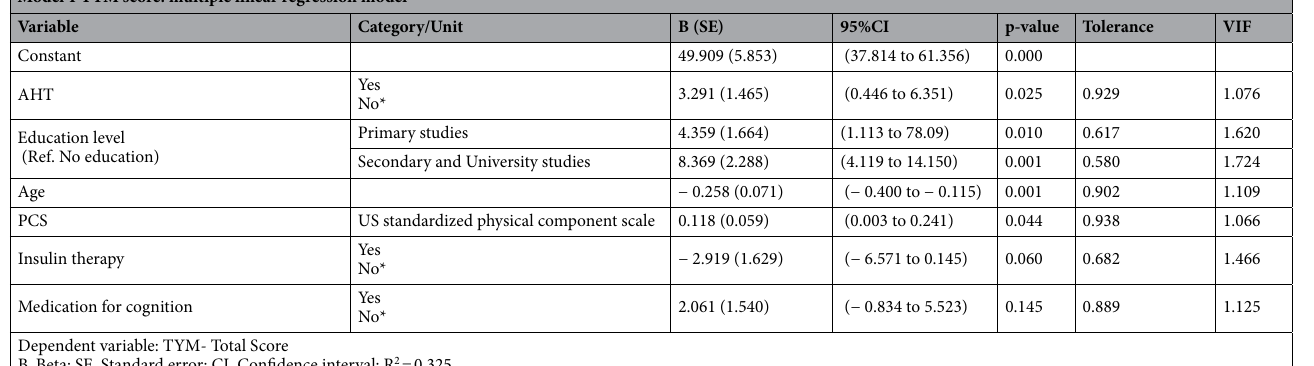
Model 1 TYM score: multiple linear regression model Variable